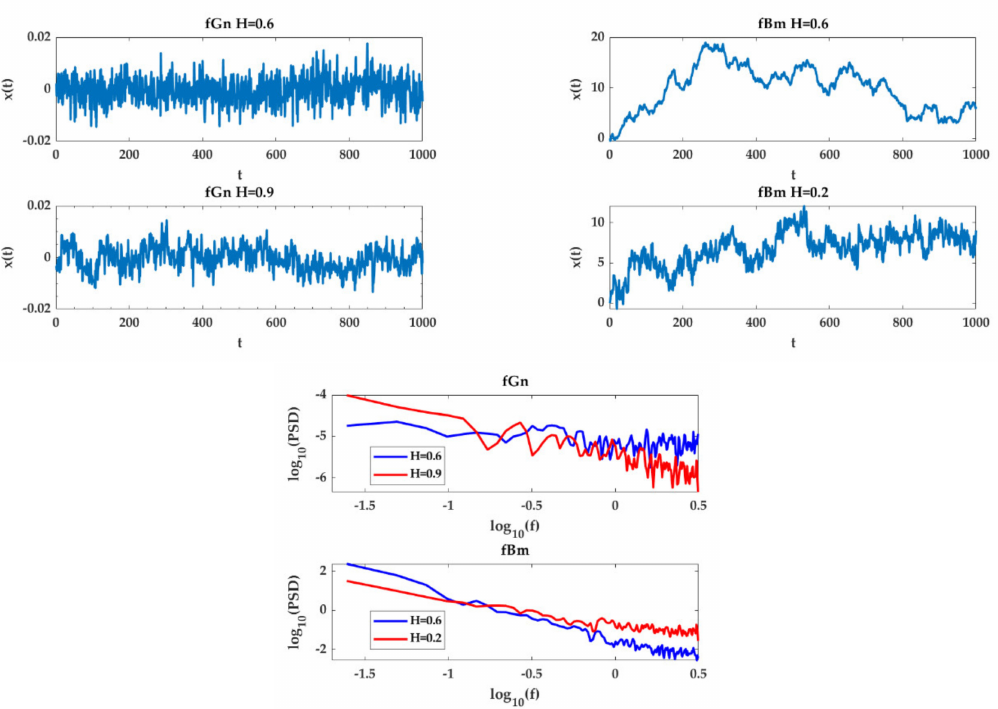
Figure 1. ( right,top ): Two realizations of a fGn with H = 0.6 ( top ) and H = 0.2 ( bottom ). ( left,top ): Two realizations of a fBm with H = 0.6 ( top ) and H = 0.9 ( bottom ). ( right,bottom ): The four corresponding PSD are plotted. Time series of 1000 observations were